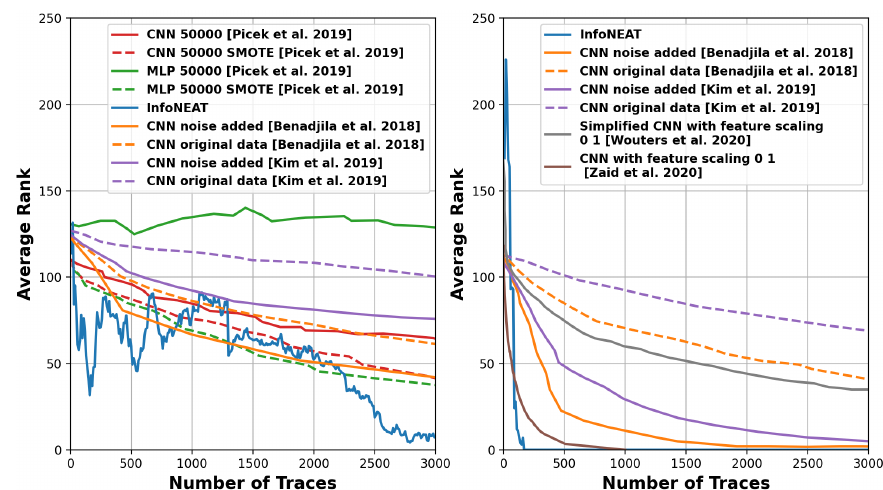
Figure 10: SOTA NNs vs. InfoNEAT for AES_HD (a) with cross-validation: T GE 50 is 2000 (InfoNEAT), 2000 (MLP with SMOTE and CNN in [BPS + 18] with noise